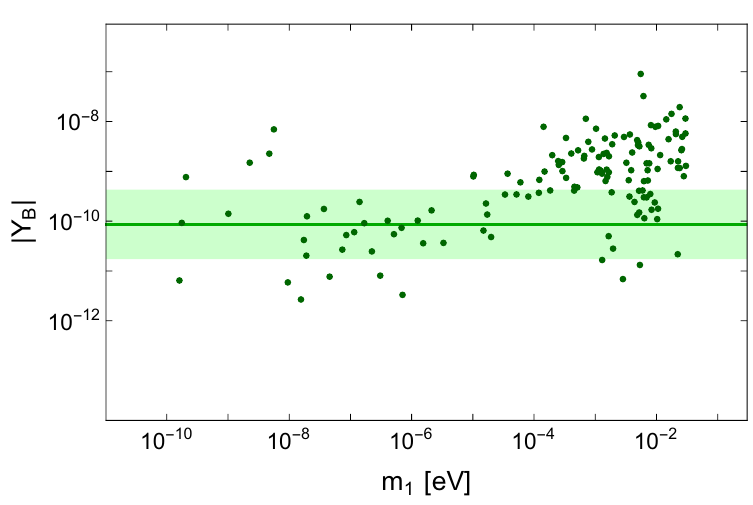
Figure 2 . Predicted baryon asymmetry as a function of the lightest SM neutrino mass in scenario I). The green line indicates the observed value, the shaded region indicates an order of magnitude